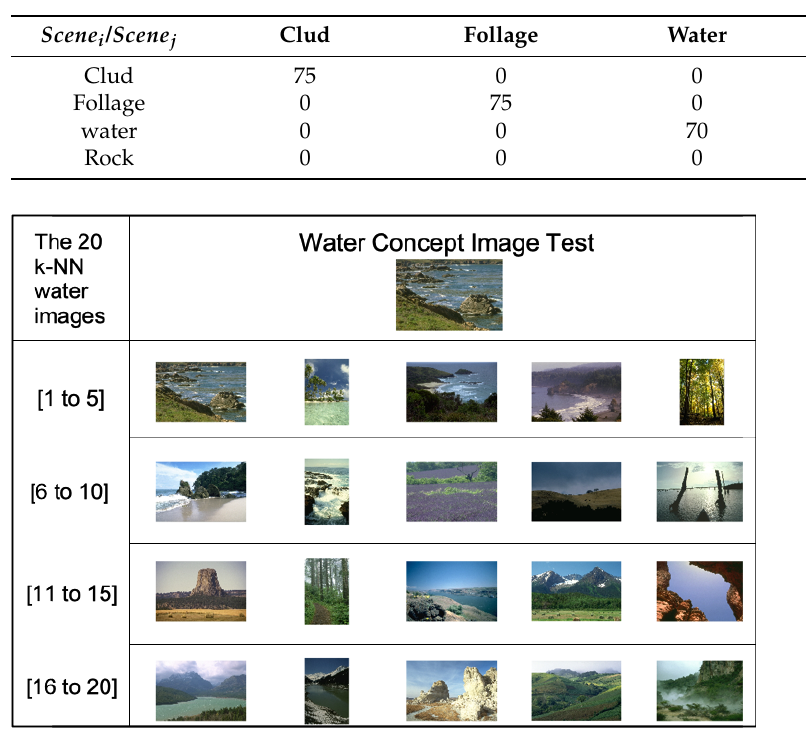
Figure 15. Retrieval results related to the concept of water.